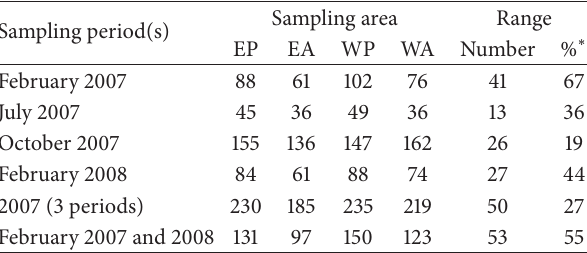
Figure 1: Morphospecies richness (both capture methods com- bined) for each sampling area in each sampling period or combi- nation of periods; EP, EA, WP, and WA are the designations of the four sampling areas. Table 1: Morphospecies richness (both capture methods) for each sampling area and period and two combinations of periods a